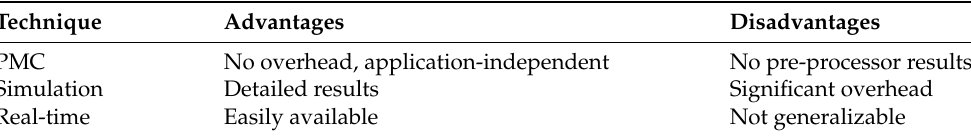
Table 1. Advantages and disadvantages of the main techniques for estimating algorithm training time. Technique